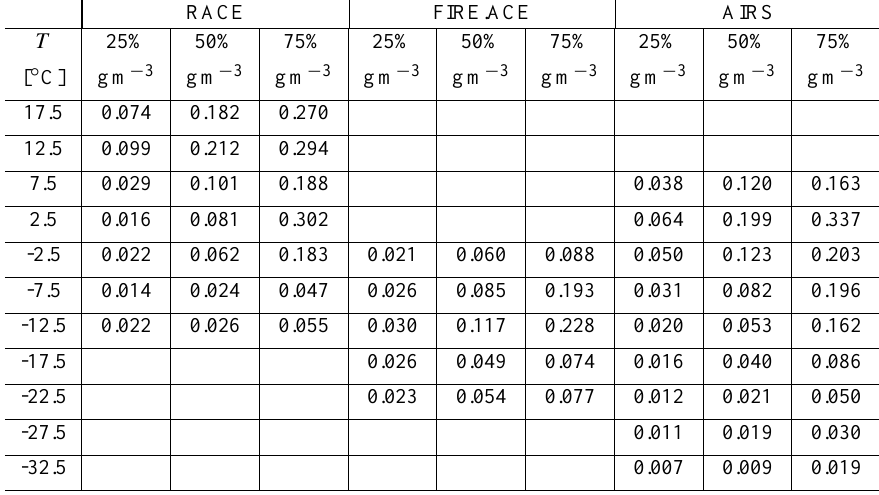
Table 2. 25%, 50% (median), and 75% values of LWC at 1T = 5 ◦ C intervals for all projects RACE FIRE.ACE